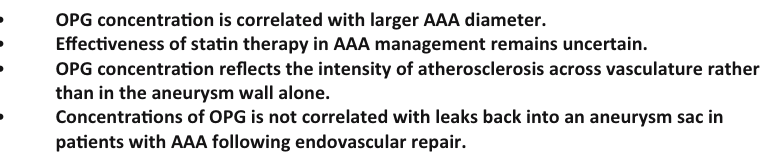
Figure 1: OPG concentrations versus